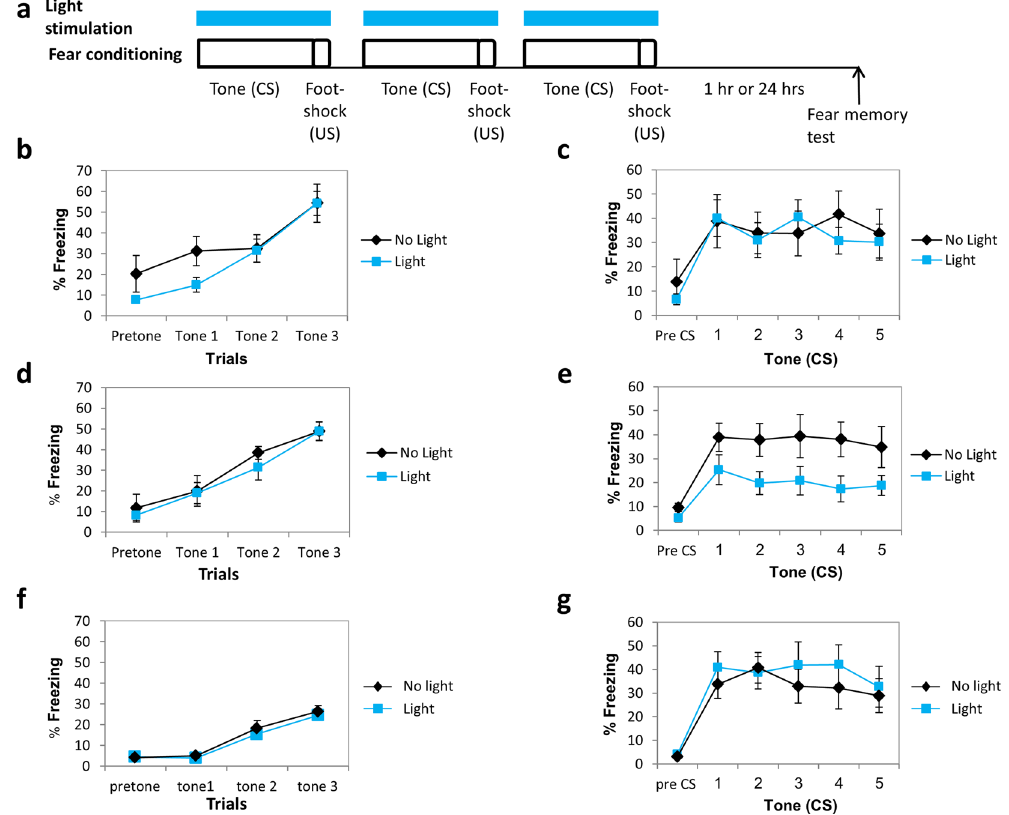
Figure 2. Activation of Rac1 GTPase in lateral amygdala impaired long-term but not short-term fear memory formation. (a) Description of the behavioral protocol. Mice injected with AAV containing PA-Rac1 were subjected to 3 tone-shock pairings. During each pairing the animals received blue light (473 nm) illumination in LA to activate the PA-Rac1. Fear memory was tested 1 hr (STM) or 24 hrs (LTM) after training. Controls were animals injected with AAV containing the PA-Rac1 and subjected to fear conditioning but without light. (b) Freezing throughout the tones presentations during training of animals used in the STM experiment subjected to light or no light control was analyzed. There is no significant difference between light and no light groups (F (1,13) = 1.214, p > 0.2). (c) There was no significant difference between the light (n = 7) and no light (n = 8) groups when tested for fear STM (F (1,13) = 0.029, p > 0.8). (d) Freezing throughout the tones presentations during training of animals used in the LTM experiment subjected to light or no light control was analyzed. There is no significant difference between light and no light groups (F (1,18) = 0.422, p > 0.5). (e) Activation of Rac1 GTPase by light during fear conditioning (n = 10) inhibited fear LTM formation compared to the no light control group (n = 10) when tested 24 hrs after training (F (1,18) = 4.671, p < 0.05). (g) Freezing throughout the tones presentations during training of animals that were not injected with virus but subjected to light or no light control that were used in the LTM experiment was analyzed. There is no significant difference between light and no light groups (F (1,17) = 0.489, p > 0.4). (f) There is no significant difference between the animals that were not injected with AAV and subjected to light and animals that were not injected with AAV and not subjected to light (F (1,17) = 0.305, p > 0.5) in the long-term fear conditioning memory